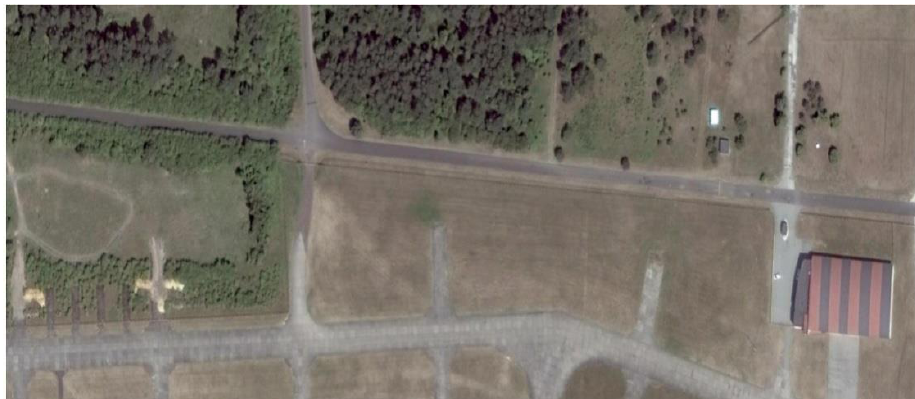
Figure 10. Aerial photography of the imaged area.